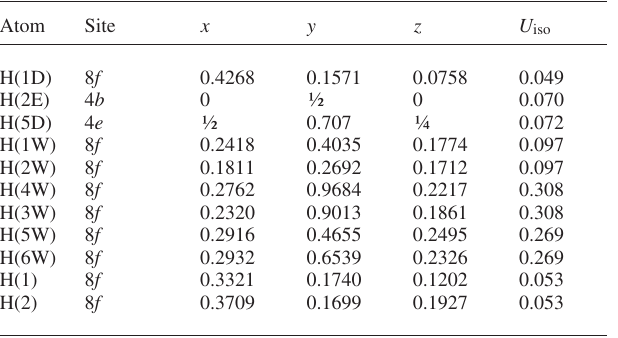
Table 2. Atomic coordinates and displacement parameters (in Å 2 )